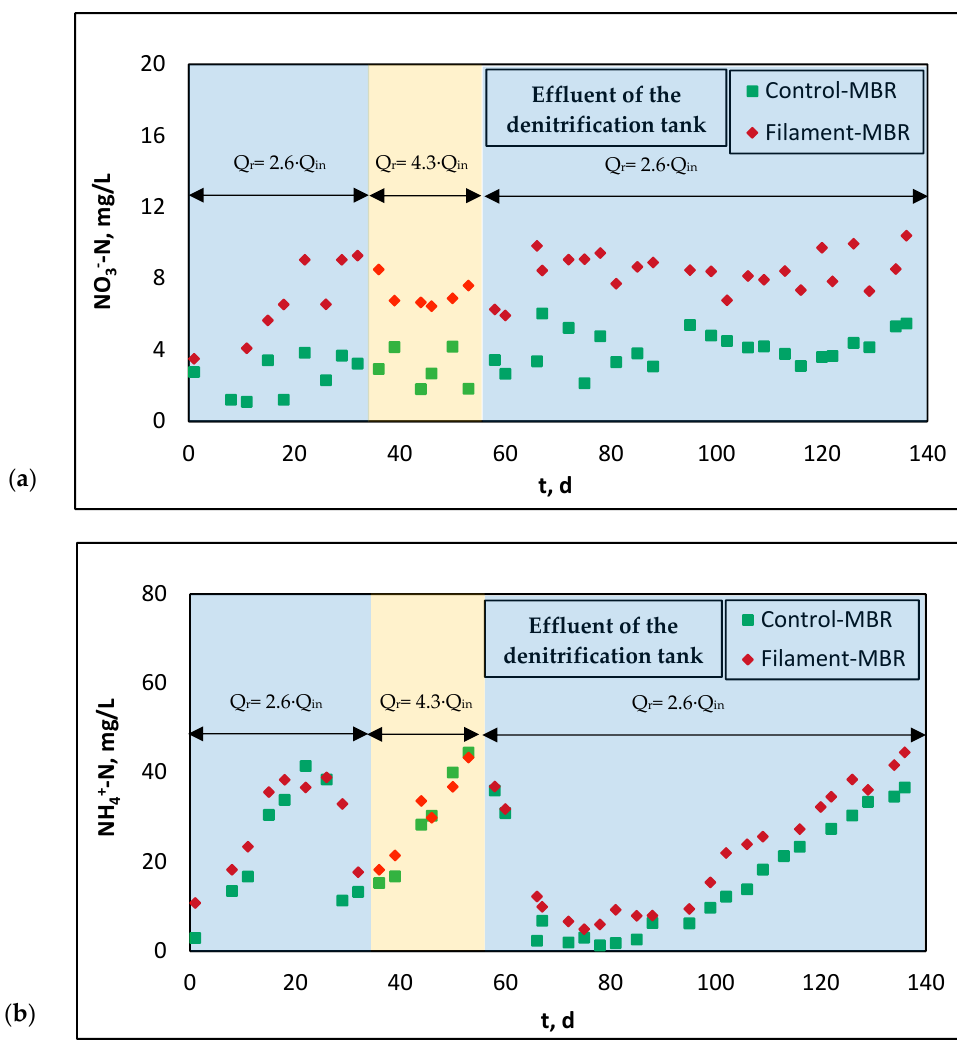
Figure 5. Evolution of: ( a ) N-NO 3 − and ( b ) N-NH 4+ concentrations in the effluent of denitrification tank for both pilot MBRs (Q r : recirculation rate, Q in : influent rate).